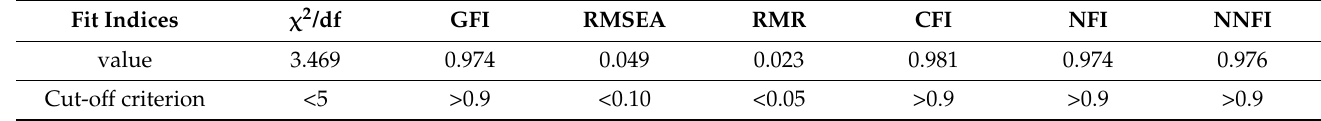
Table 7. Model Fit Measures (Recommended